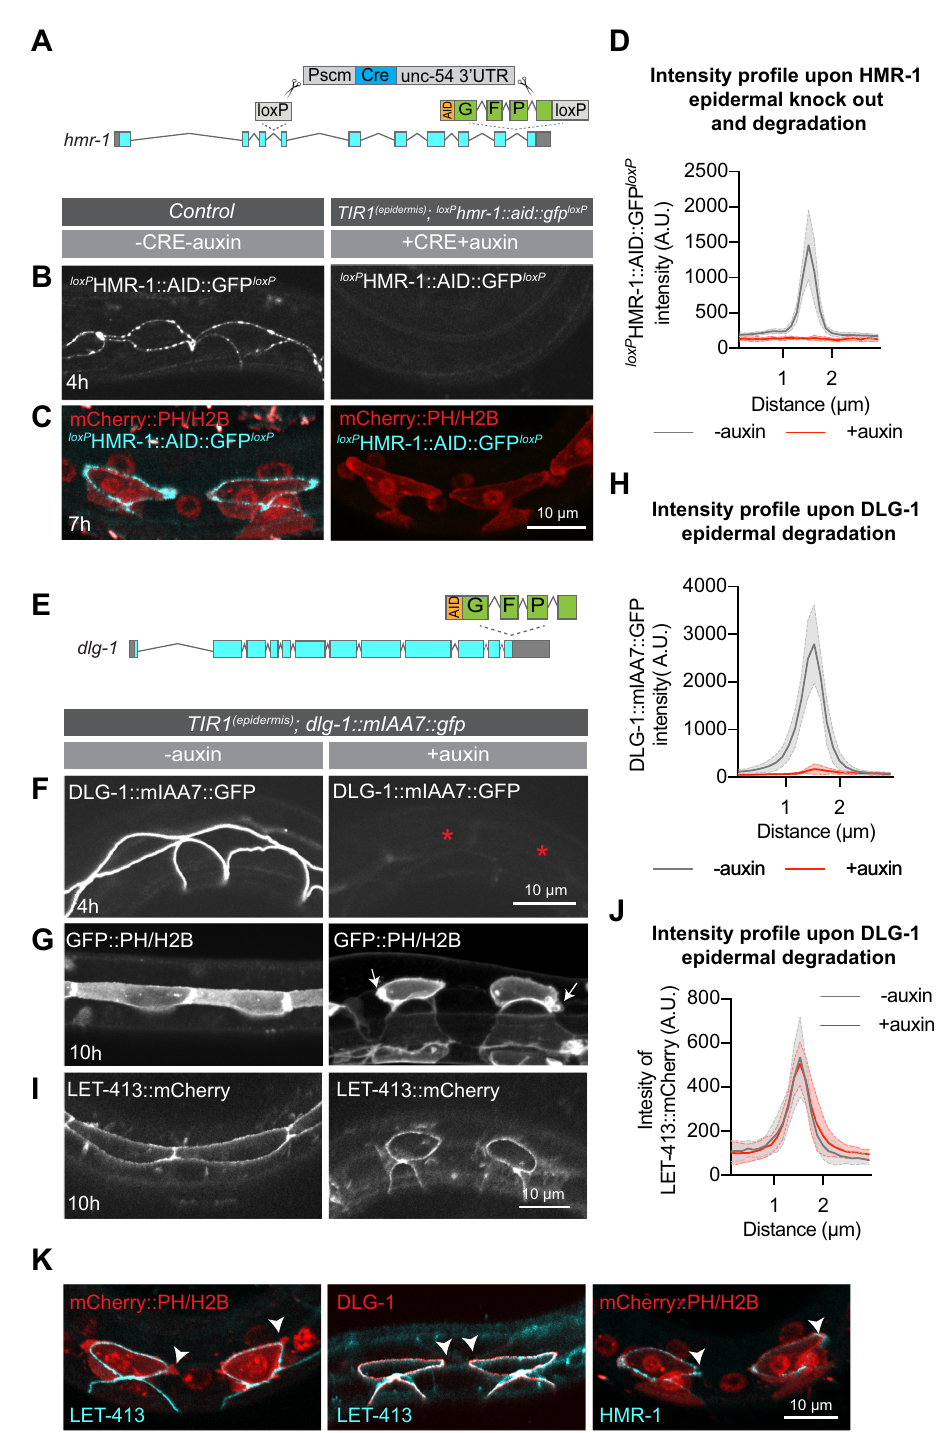
Fig 6. LET-413 acts upstream of DLG-1 in the regulation of the seam cell outgrowth. ( A ) Schematic representation of hmr-1 depletion approach used (J. Cravo and S. van den Heuvel, manuscript in preparation). ( B, C ) Distribution of HMR-1 and the mCherry::PH and mCherry::H2B markers in the seam cells of control and HMR-1-depleted animals, 4 and 7 h after hatching. Images are maximum projections of the apical domain of the seam cells. Genotypes are hmr-1 :: LoxP :: AID :: GFP :: loxP;Pwrt2 :: mCherry :: PH Pwrt-2 :: mCherry :: H2B for the control (strain SV2496) and hmr-1 :: LoxP :: AID :: GFP :: loxP; Pscm :: CRE; Pwrt-2 :: TIR1 :: BFP; Pwrt2 :: GFP :: PH Pwrt-2 :: GFP :: H2B for the auxin-treated animals (strain SV2479). ( D ) Quantification of HMR-1 intensity across the hyp7–seam junction in animals depleted of